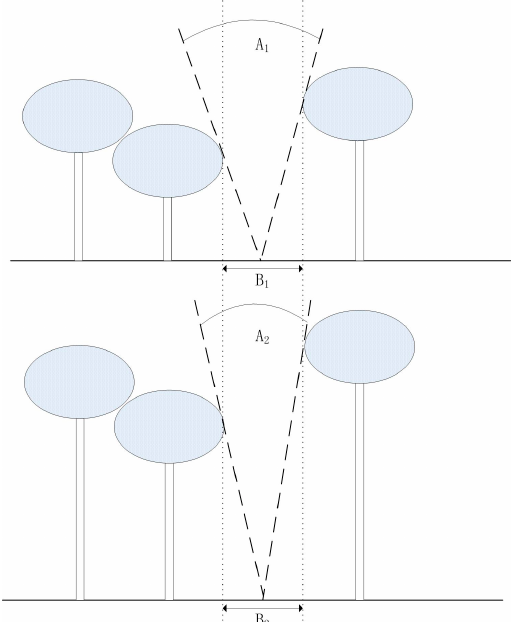
Figure 8. For tree crown of a given size, canopy cover (B) is independent of canopy height, but canopy closure (A) is dependent of canopy height. In this example, B 1 = B 2 , but A 1 > A 2 [63]. Profile analysis was used to indicate continuous forest-richness in altitudinal vegetation zones.